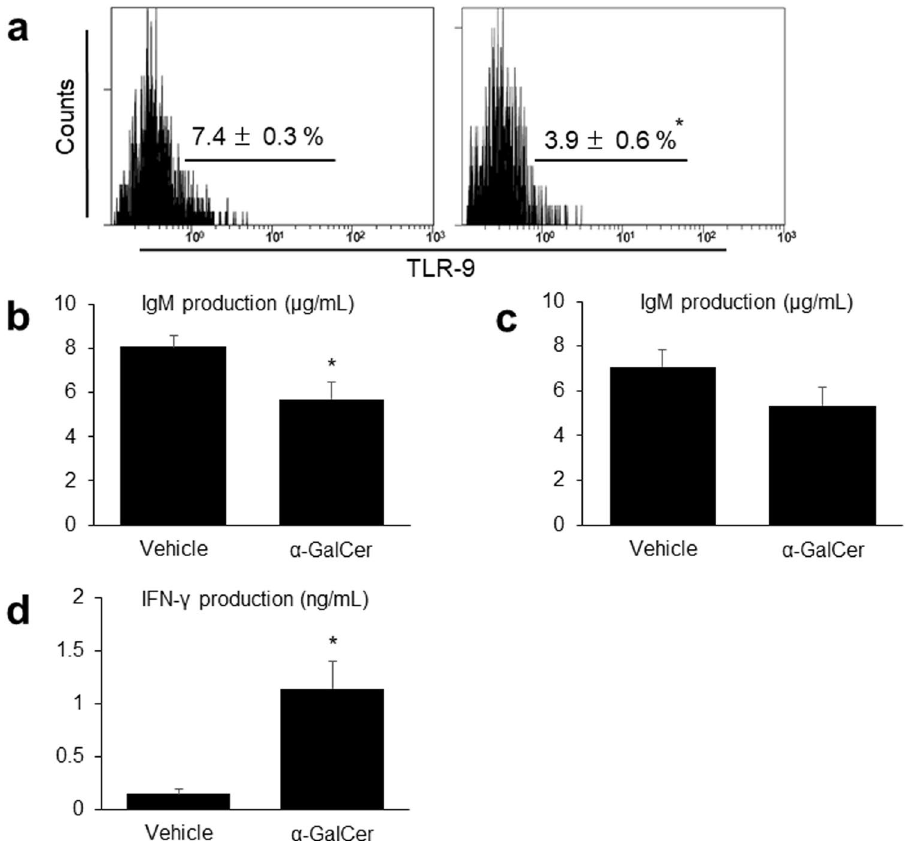
Figure 8. A decrease in B cell function and augmentation of NK cell function is observed in (NZB/NZW) F1 (BWF1) mice treated with alpha-galactosylceramide ( α -GalCer). ( a ) Representative histograms obtained by flow cytometry showing the expression of intracellular Toll-like receptor-9 (TLR-9) in splenic F4/80 + CD11b + macrophages in the vehicle (left) and α -GalCer (right) groups of BWF1 mice. The data represent the mean ± SEM in each group ( n = 4 in each group). IgM production by spleen mononuclear cells (MNCs) stimulated with ( b ) CpG-oligodeoxynucleotide (CpG-ODN) or ( c ) lipopolysaccharide for 48 hours in each group ( n = 4–6 in each group). ( d ) IFN- γ production by liver MNCs stimulated by CpG-ODN for 48 hours in each group ( n = 4 in each group). * p < 0.05 compared with the vehicle